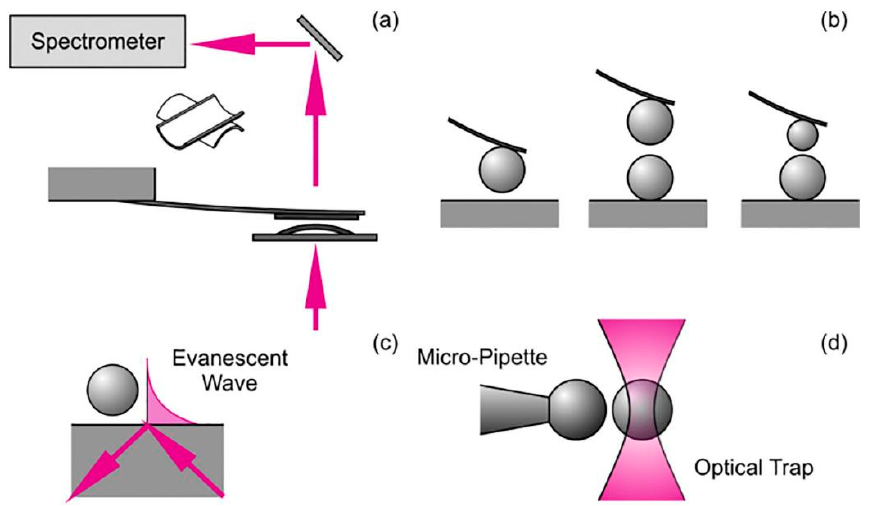
Figure 9. Schematic diagram of tools for direct force measurements. ( a ) Surface force apparatus (SFA); ( b ) Atomic force microscopy (AFM); ( c ) Total internal reflection properties (TIRM); and ( d ) Optical tweezers. Reprinted with permission from Ref. [127]. 2020, Elsevier.